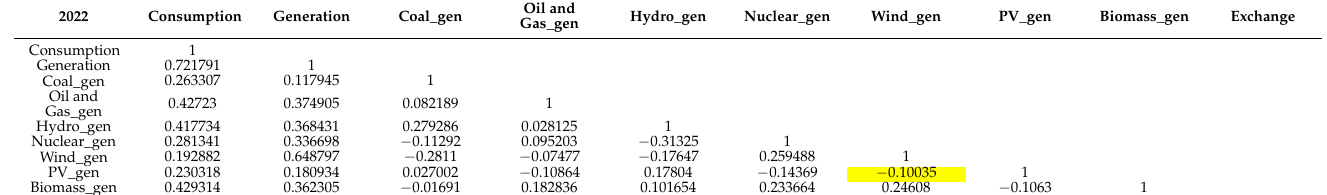
1 Table 4. Correlation coefficients between consumption and generation sources in 2022. 2022